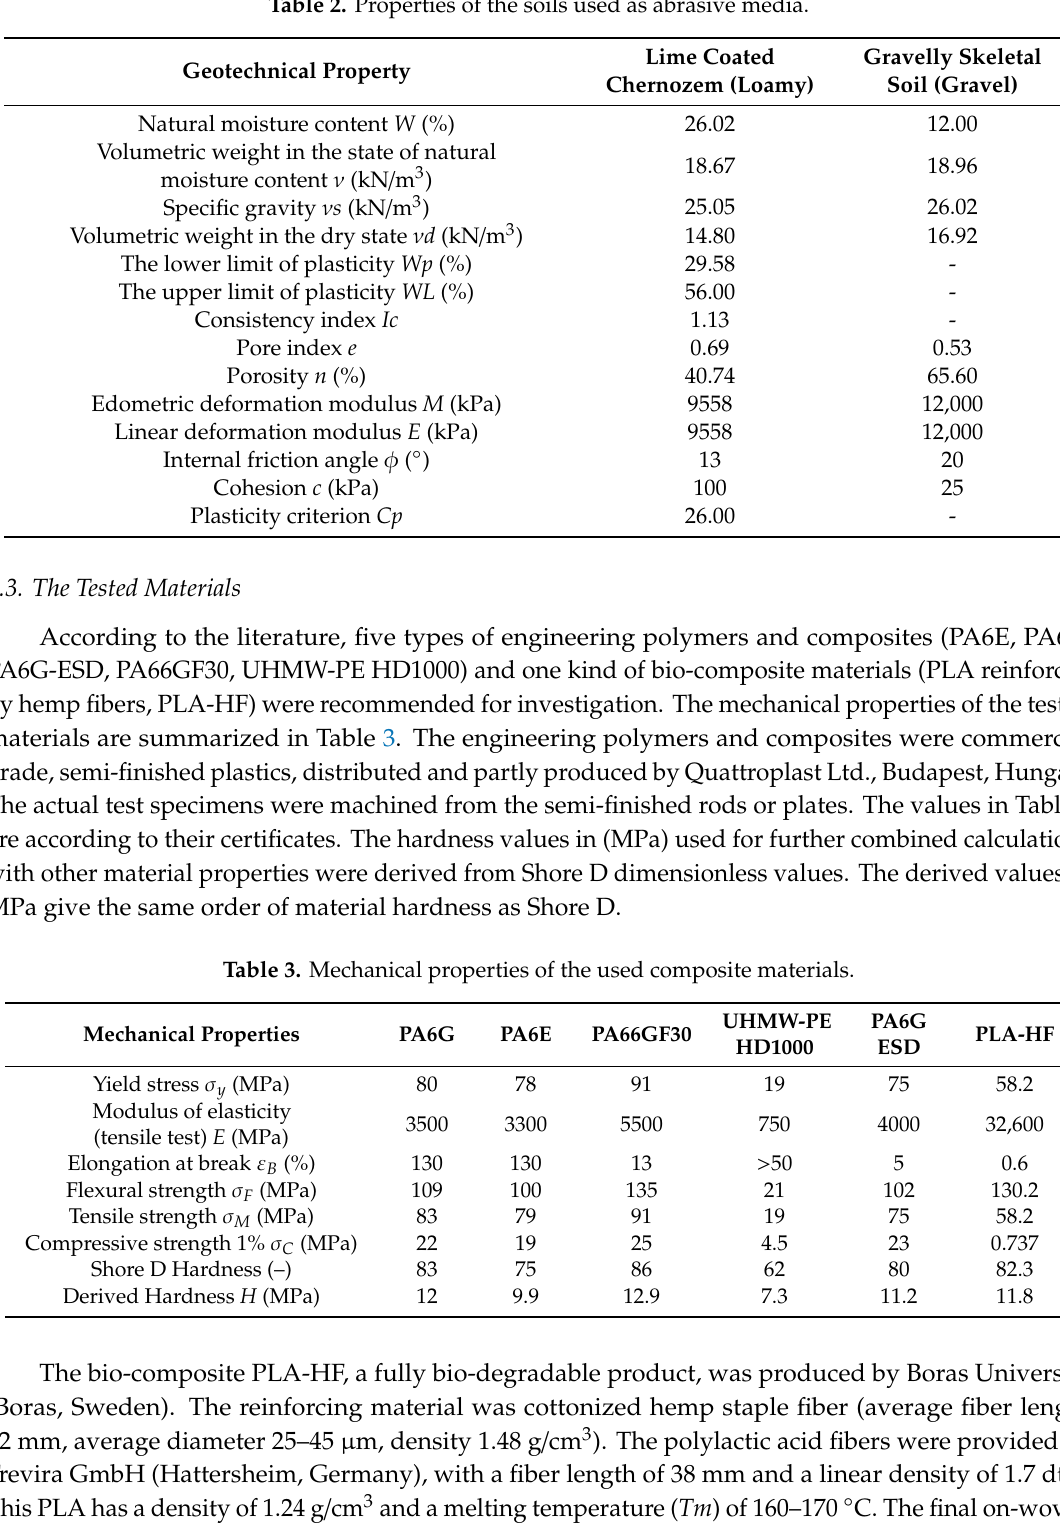
Table 2. Properties of the soils used as abrasive media.